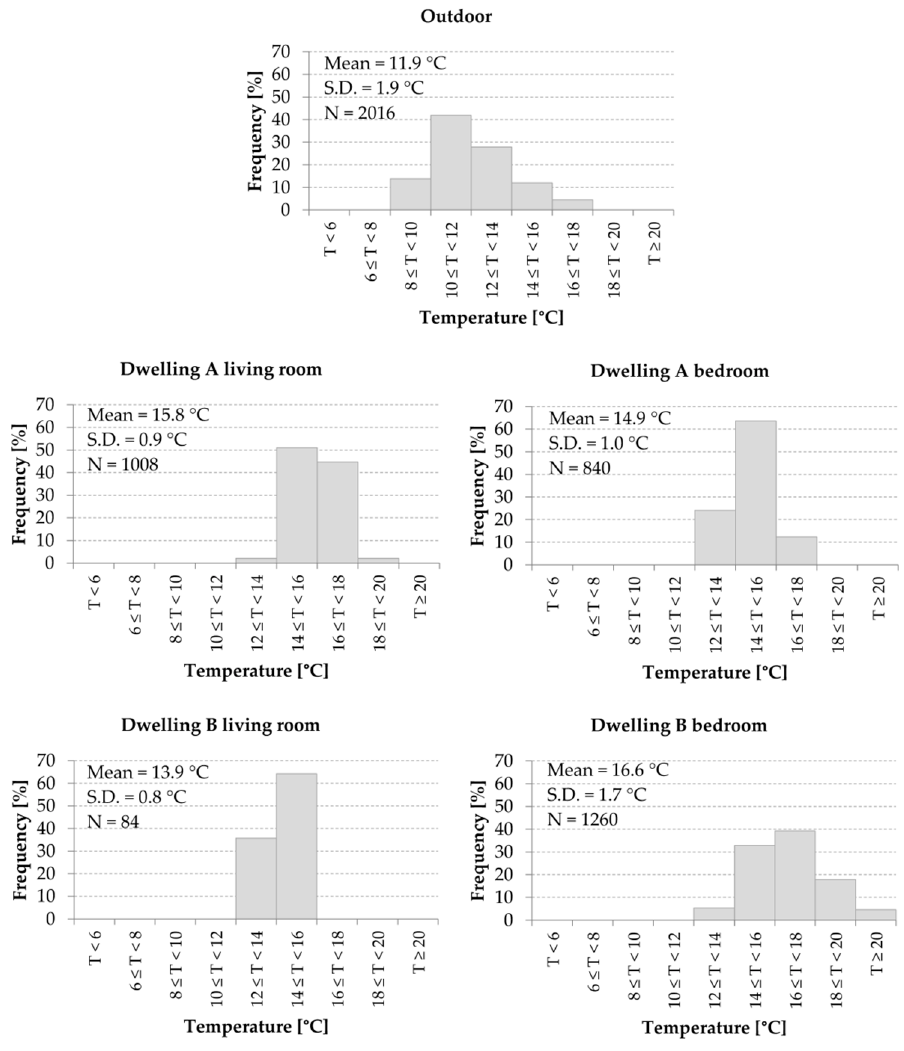
Figure 5. Air temperature